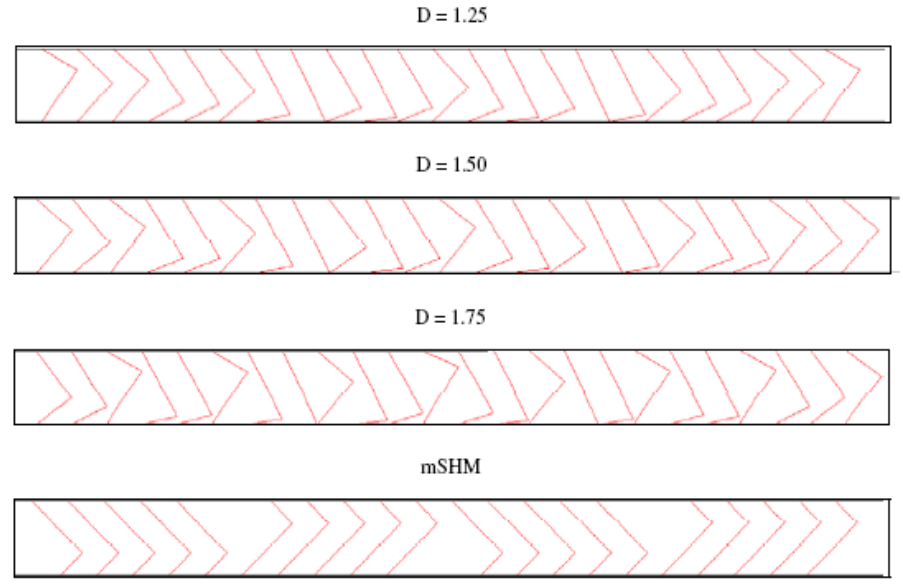
Figure 16. Top view of the channel designs with different fractal patterning of bottom grooves and mSHM (modified staggered herringbone mixer) (from Camesasca et al.